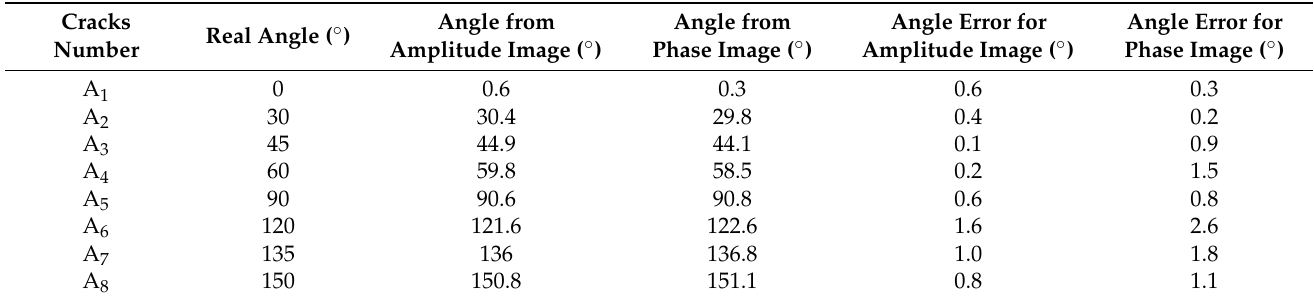
Figure 20. 2D images of ( a ) amplitude and ( b ) phase at the 60 kHz excitation frequency for cracks of various orientations on a PCB. Table 4. Orientation of cracks extracted from 2D